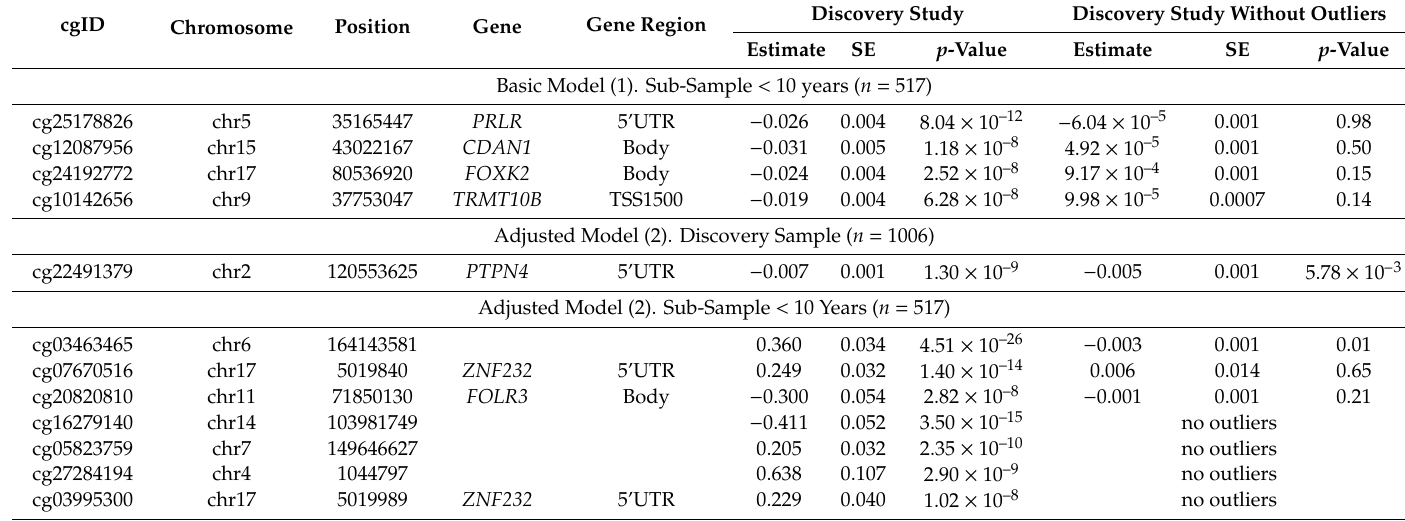
Table 2. Summary of epigenome-wide significant CpGs from the discovery epigenome-wide association study (EWAS) of DNA signatures of breastfeeding. Discovery Study Discovery Study Without Outliers cgID Chromosome Position Gene Gene Region Estimate